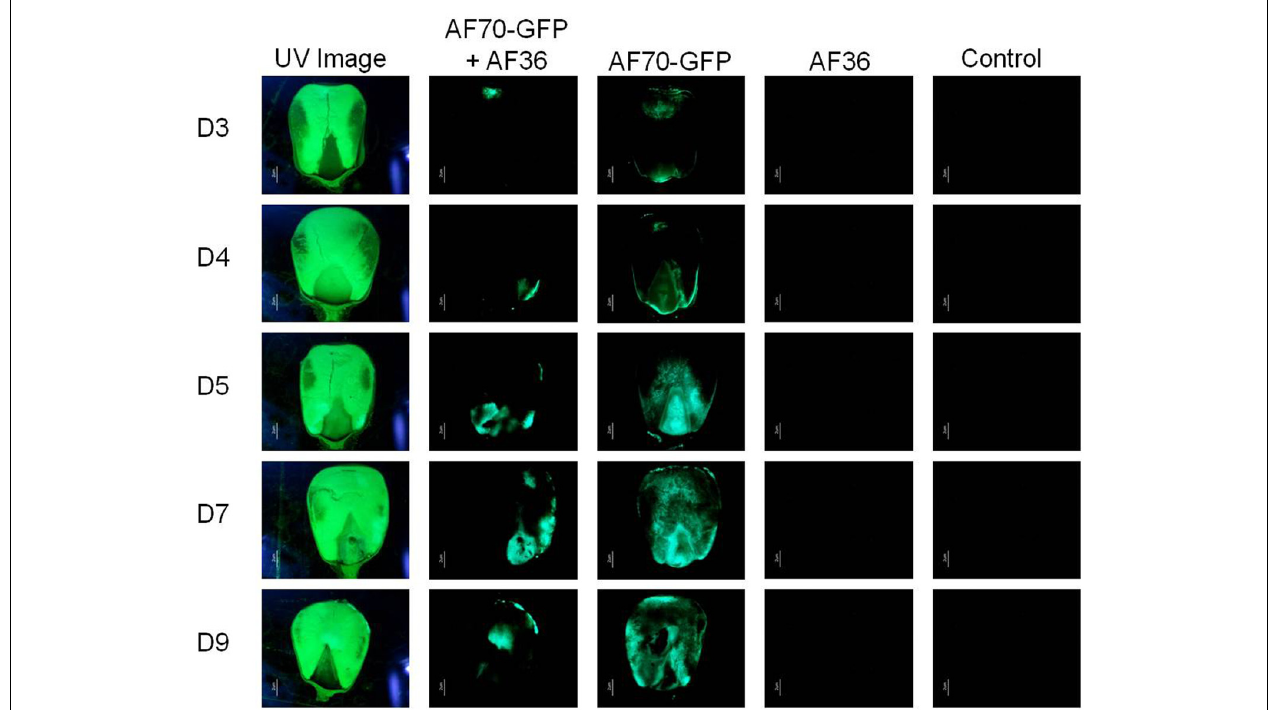
FIGURE 2 | Fluorescence images representing inoculation treatments observed using UV light (first column) and using a GFP filter (columns two through five) for each day of examination (day 3–day 9; D3–D9).